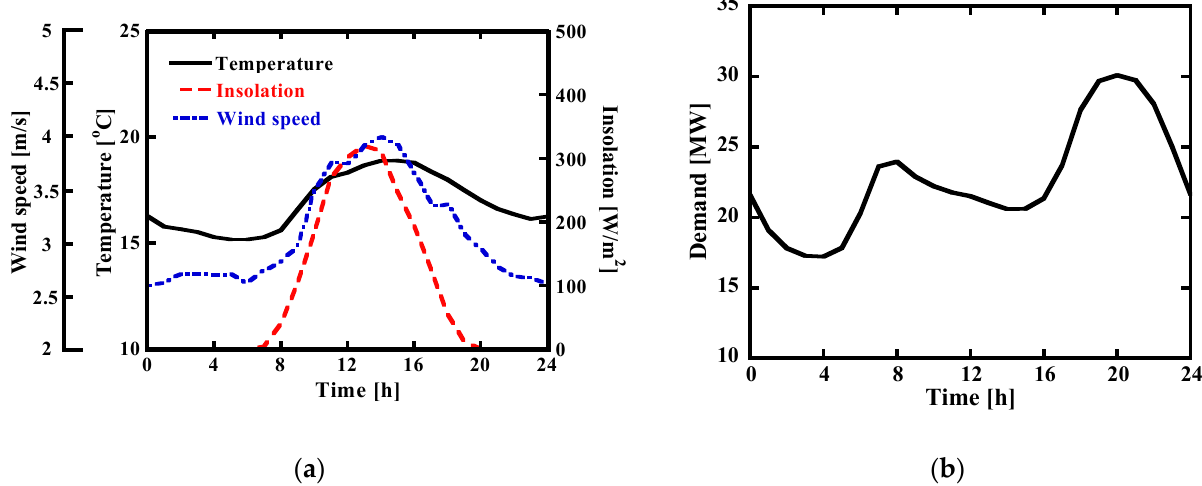
Figure 3. Annual average ( a ) weather conditions and ( b ) demand profile.